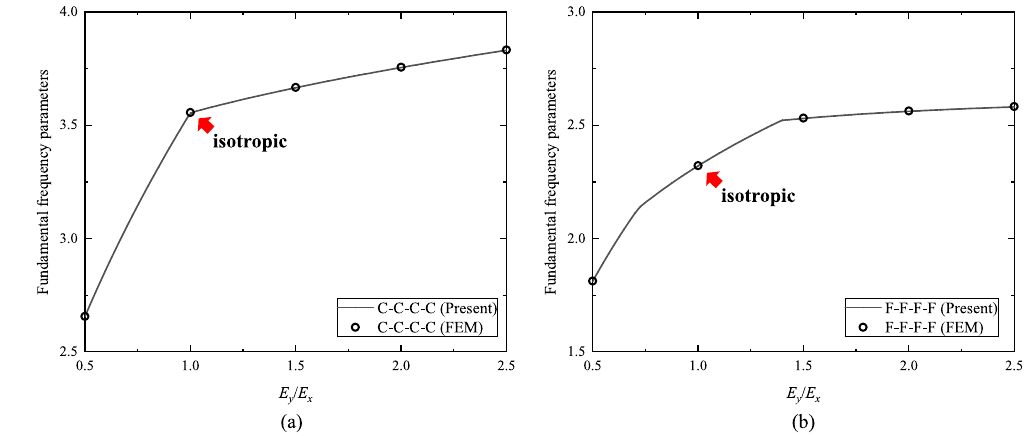
Figure 5. Fundamental frequency parameters ( (cid:31) ort ) versus E y and ( b ) orthotropic F–F–F–F square plates, with ν x ν y = ( 0.3 )